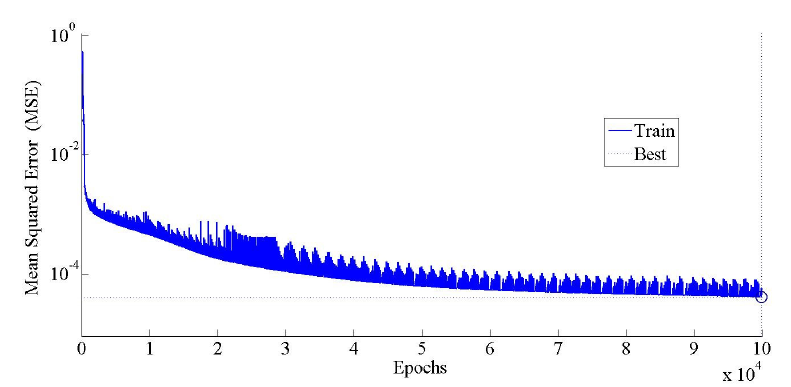
Figure 4. Predicted MSE with respect to the number of epochs. Table 5. Parameters of the artificial neural network model.